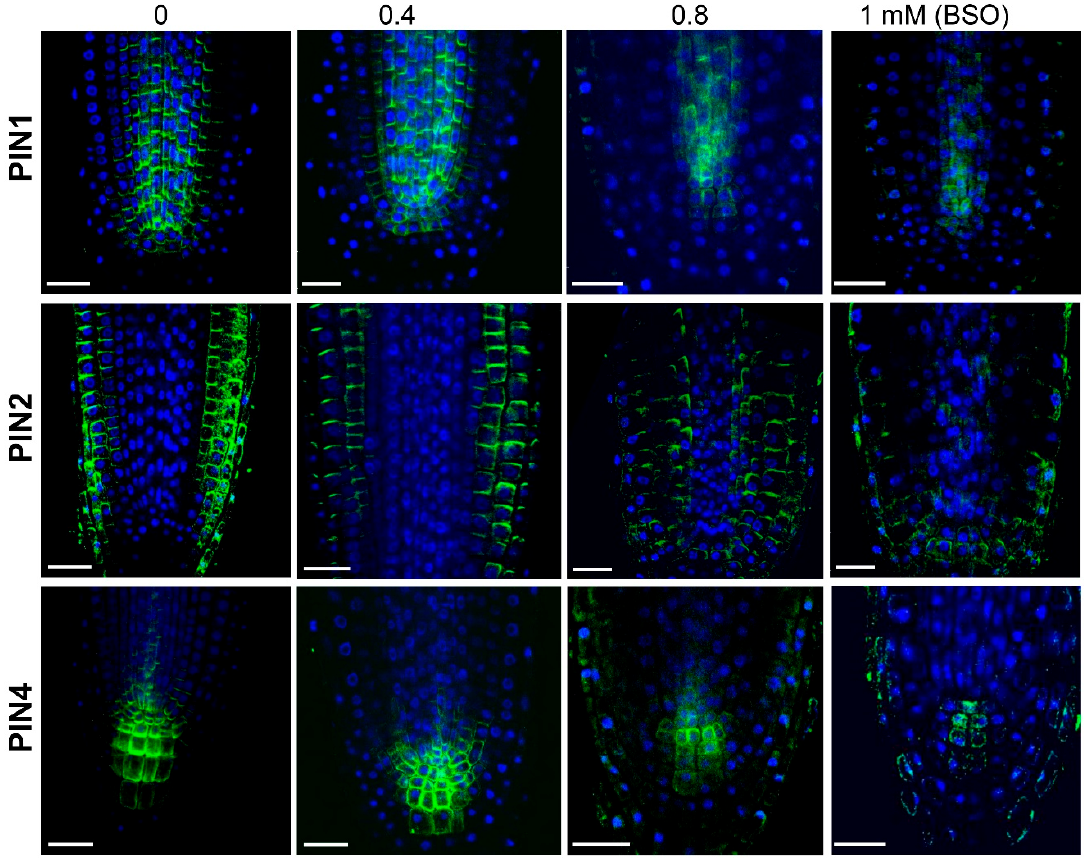
Figure 6. GSH level altered the PIN signal localization in the RAM. PIN1, PIN2, and PIN4 expression and localization in the RAM of Arabidopsis seedlings grown in a medium with different L-buthionine-(R,S)-sulfoximine (BSO) concentrations. Scale bar − 20 µm.